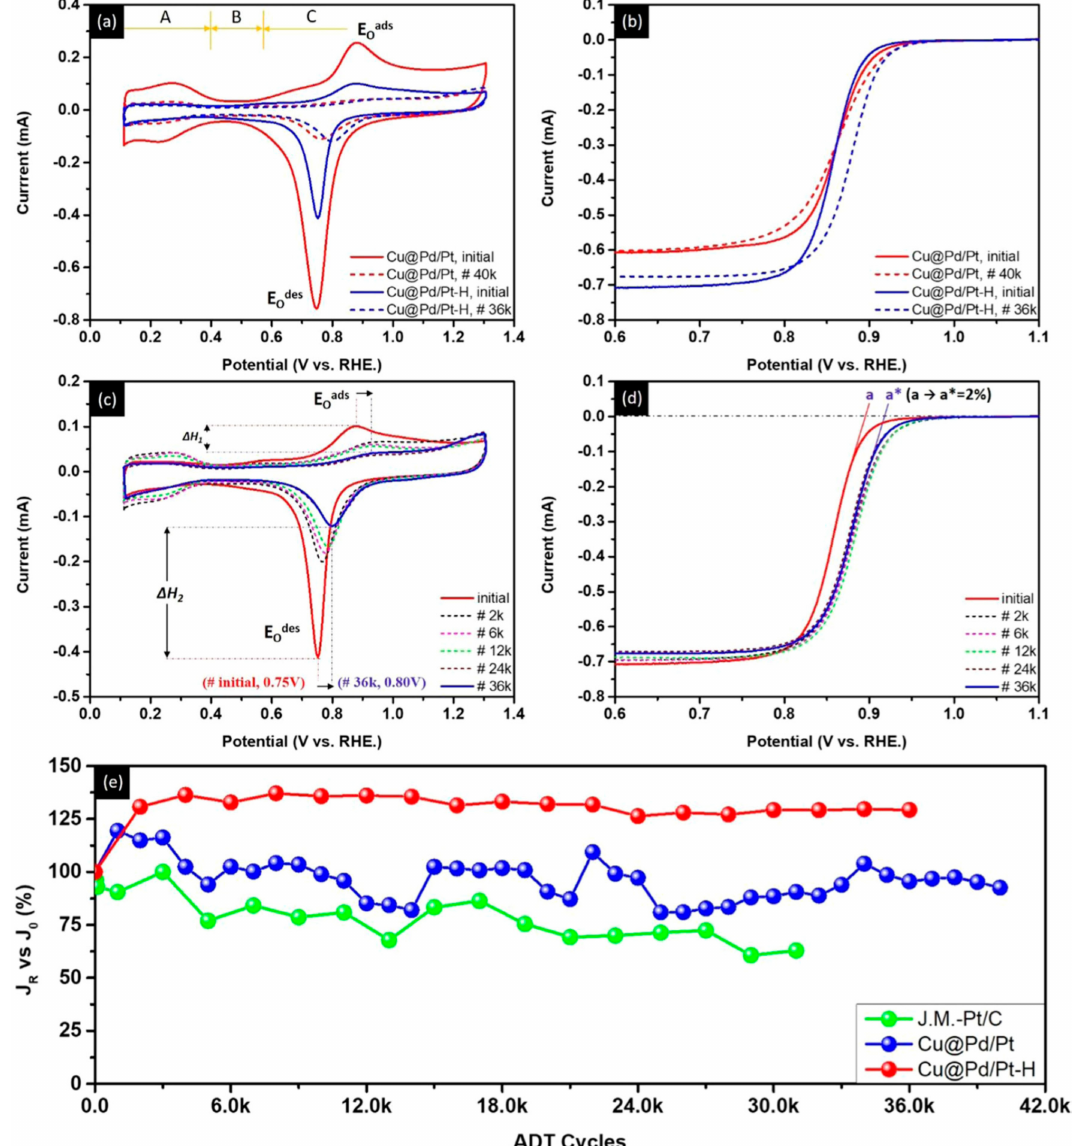
Figure 7. ( a ) The cyclic voltammetry and ( b ) linear sweep voltammetry curves of pristine (Cu@Pd / Pt) NCs and NCs after annealing (Cu@Pd / Pt-H). ( c ) The cyclic voltammetry and ( d ) linear sweep voltammetry curves of Cu@Pd / Pt-H NCs at stability test cycles. ( e ) Normalized current densities of Cu@Pd / Pt, Cu@Pd / Pt-H, and commercial J.M.-Pt / C catalysts at selected accelerated degradation test (ADT) cycles. (Reproduced with permission from [49], ACS Publications,